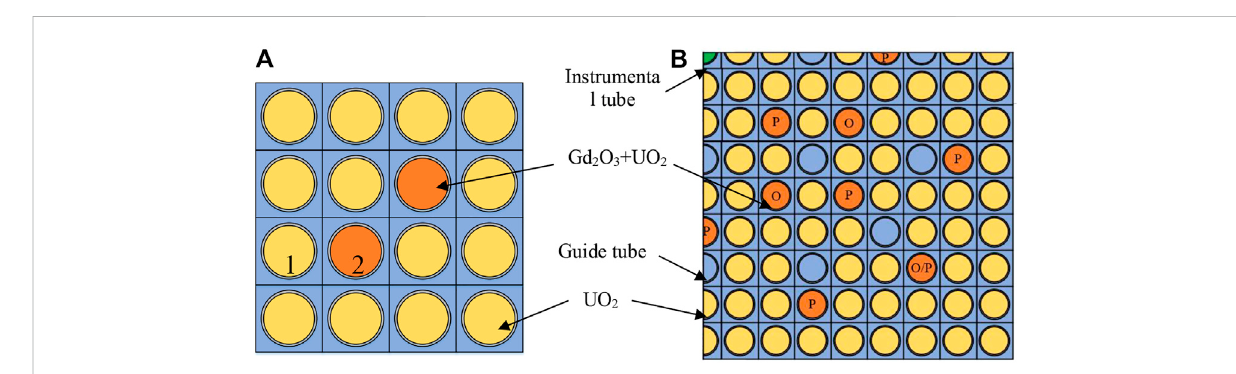
FIGURE 12 Structural con fi guration of the lattice with gadolinium pins: (A) BWR 4 × 4; (B) VERA